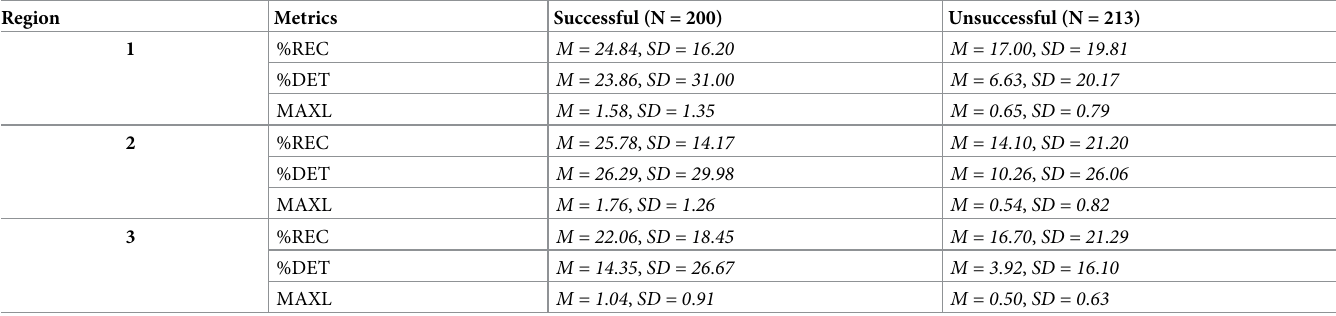
Table 3. Descriptive statistics for region-based MdRQA for successful and unsuccessful trials. Region